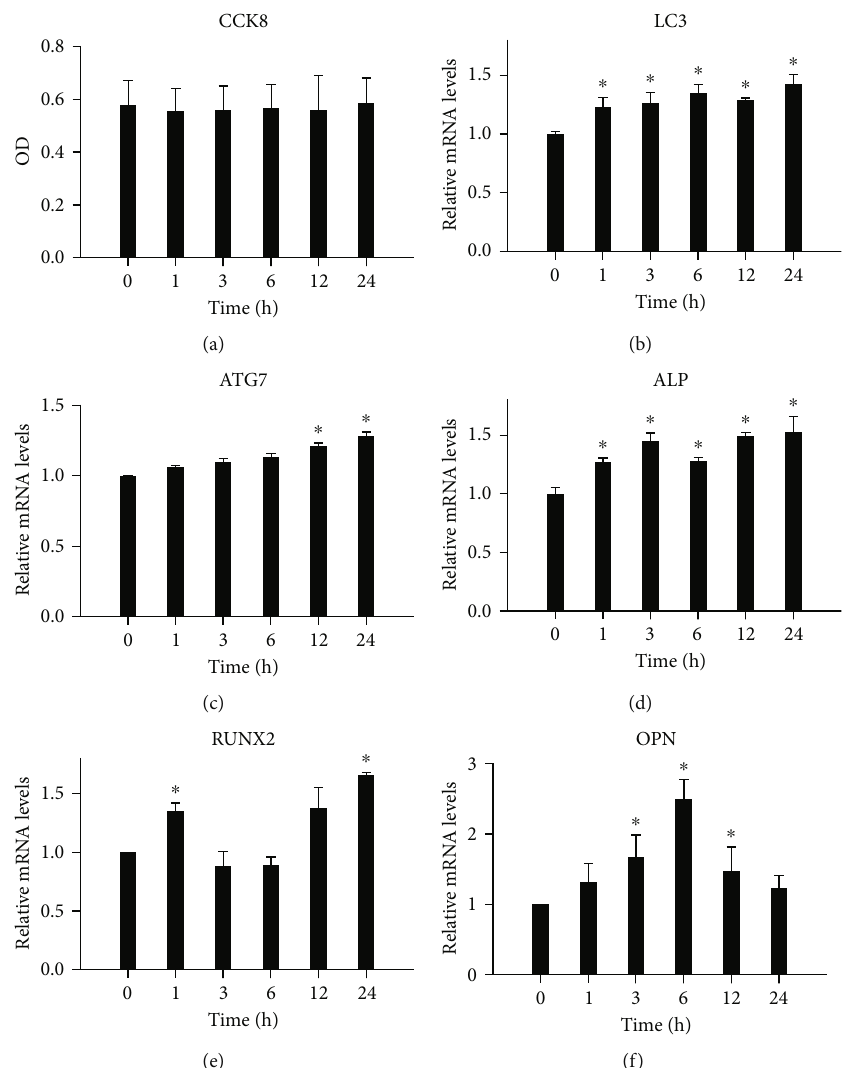
Figure 2: Changes in osteogenic and autophagy levels under mechanical stretch. (a) Cell proliferation activity detected using the CCK-8 kit. (b – f) LC3-, ATG7-, ALP-, RUNX2-, and OPN-relative mRNA expression levels assessed by real-time PCR at 0, 1, 3, 6, 12, and 24h. ∗ P < 0 : 05 . OD: optical density; PCR: polymerase chain